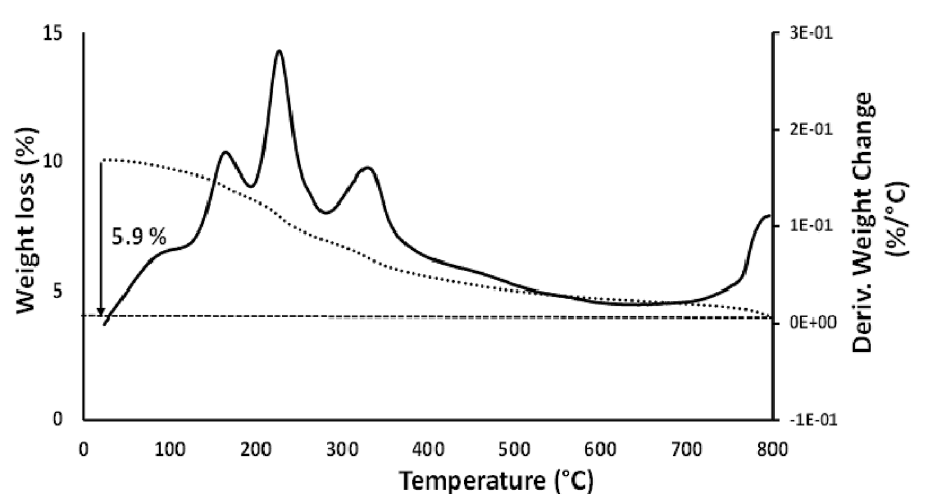
Figure 6. Date fruit melanin thermogravimetric analysis (TGA) represented by dashed line and differential thermogravimetry (DTG) by solid